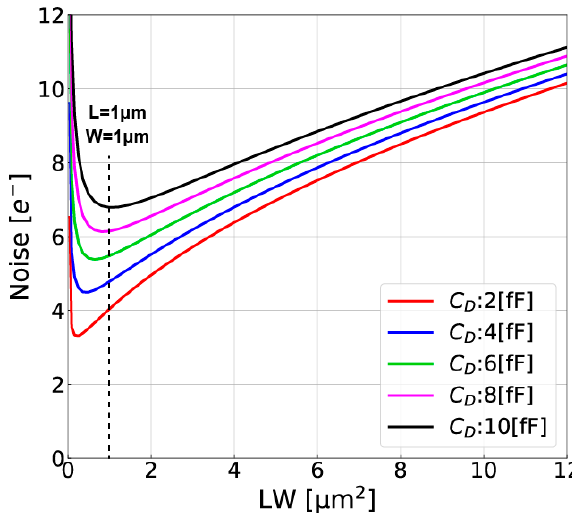
Figure 11. Input-referred Noise as a Function of LW of MP1 and C D .